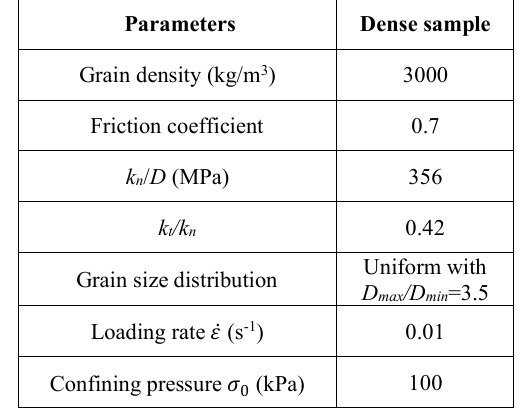
Table 1 . Dense sample parameters for the triaxial test. D is the mean diameter of the